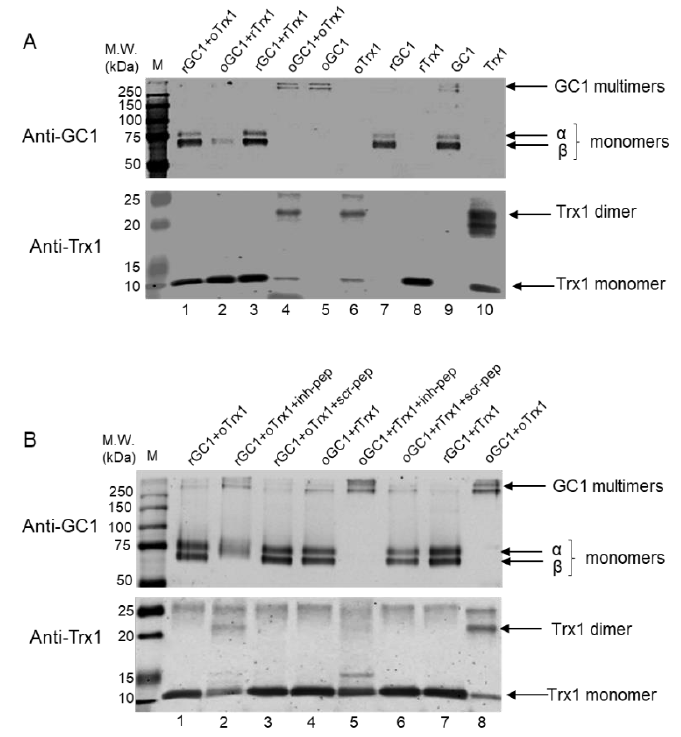
Figure 2. Representative Western blots showing reduced activity of rGC and rTrx1 toward oTrx1 and oGC1, respectively, and blocking of these activities by the inhibitory peptide. ( A ), Purified GC1 and Trx1 were oxidized or reduced as described in Methods and the various oxidized and reduced forms were mixed (molar ratio 1:5) as indicated on the top of the blots (lanes 1–4), then separated by electrophoresis on a non-reducing 12% SDS-PAGE gel. After transfer, the blots were probed with GC1 anti- α and anti- β (upper panel), and anti-Trx1 (lower panel) antibodies. The corresponding reducing gel is provided in Figure S5. Lane 5–8 are the oxidized and reduced forms of Trx1 and GC1, lanes 9 and 10 are untreated GC1 and Trx1. M.W. for Molecular Weight markers. n = 3 independent experiments. ( B ) , The oxidized and reduced forms of Trx1 and GC1 were mixed as above in the presence of DMSO (lane 1 and 4), 125 µ M inhibitory peptide (inh-pep, lane 2 and 5) or scramble peptide (scr-pep, lane 3 and 6), before being transferred and probed as in 2A. Lane 7–8 are controls of reduced or oxidized forms of GC1 and Trx1 mixed together. The corresponding reducing gel is provided in Figure S6. n = 3 independent experiments.